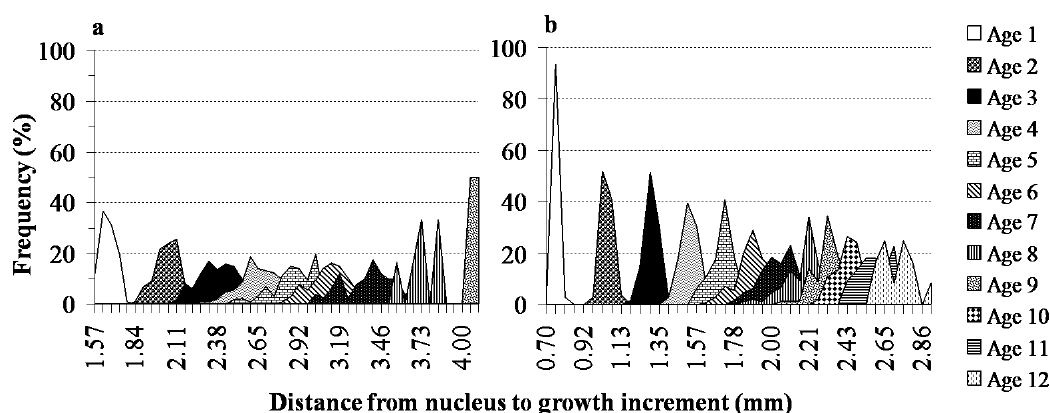
Fig . 3. – individualisation of growth increments by age from Aphanopus carbo otoliths caught off mainland Portugal. (a) Age assignment procedure in posterior region of whole otoliths. (b) Age assignment procedure in dorsal face of sectioned otoliths.